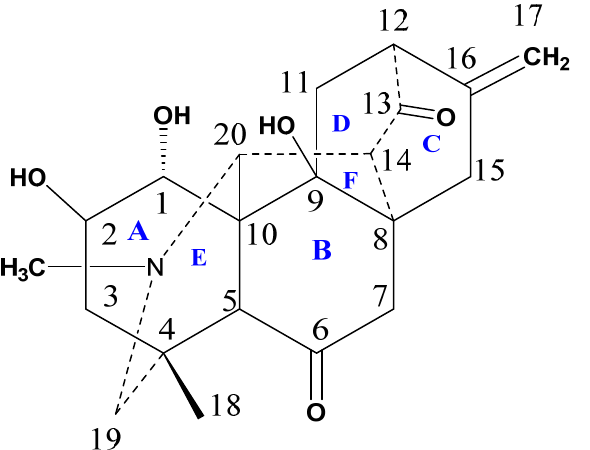
Figure 5. Structure of Compound 1 , orientation of different rings and groups are shown accordingly.